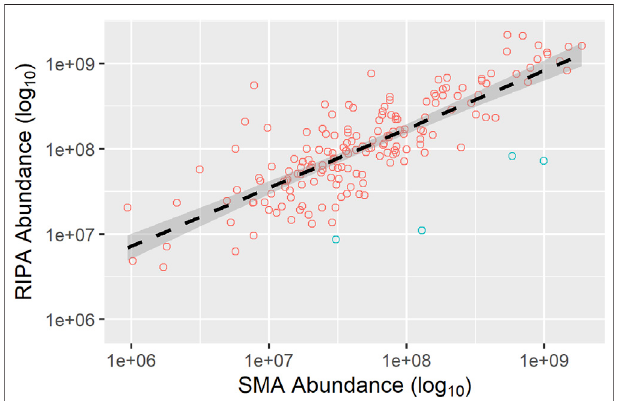
FIGURE9| CorrelationoftheabundanceofTMproteins commontothe pull-downs from SMA and RIPA extracts. Abundances (area value) of TM proteins were taken from datasets of the pull-downs from SMA ( x -axis) and RIPA( y -axis)extracts(washprotocol3),andplottedasascatterplot.TM proteins which have higher abundance ( > 3-fold) in the pull-downs from the SMA extract than from the RIPA extract are highlighted (blue circles). The regression line (black dashed) and 95% con fi dence interval (dark gray shaded area) are shown. Equation for regression line is y (cid:2) 539.96 × 0.6876. Pearson ’ s correlation coef fi cient, r (cid:2)